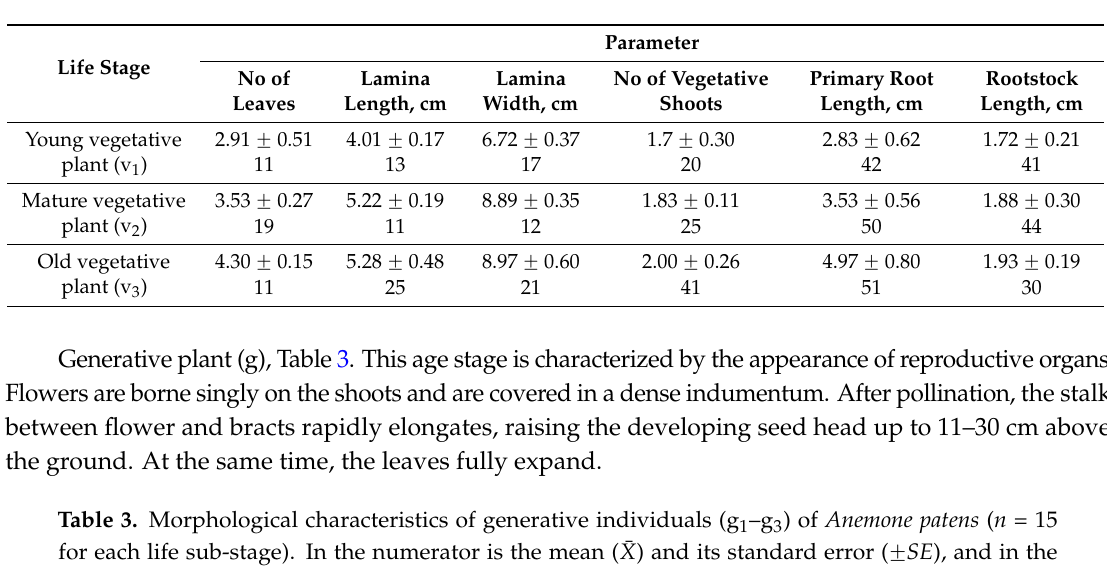
Table 2. Morphological characteristics of vegetative individuals (v 1 –v 3 ) of Anemone patens ( n = 15 for each life sub-stage). In the numerator is the mean ( ¯ X ) and its standard error ( ˘ SE ), and in the denominator the coefficient of variation (% CV ).